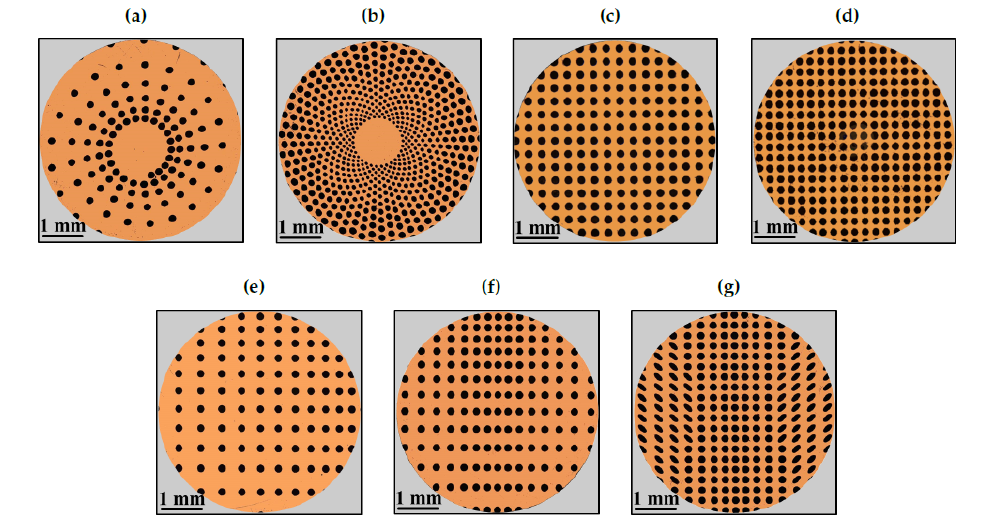
Figure 3. Optical microscope images of patterns fabricated on 100Cr6 steel spheres-( a ) Nautilus; ( b ) Sunflower; ( c ) Grid (VR=33%); ( d ) Grid (44%); ( e ) Diagonal; ( f ) Hydrostep; ( g )